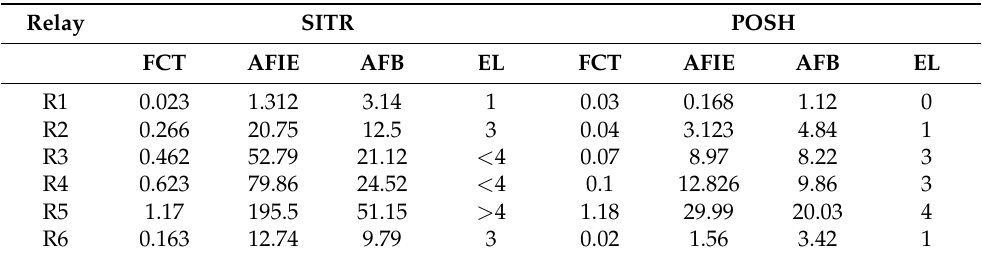
Table 6. The results of SITR and POSH approaches in term of (FCT, AFIE, AF, and EL) in Mode 1.